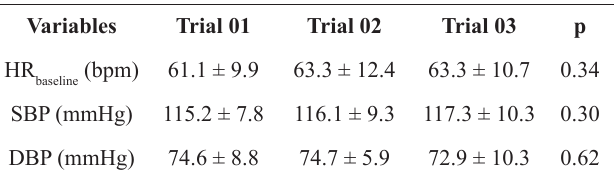
Table 1: The mean and standard deviation of resting hemodynamics variables assessed on three occasions.